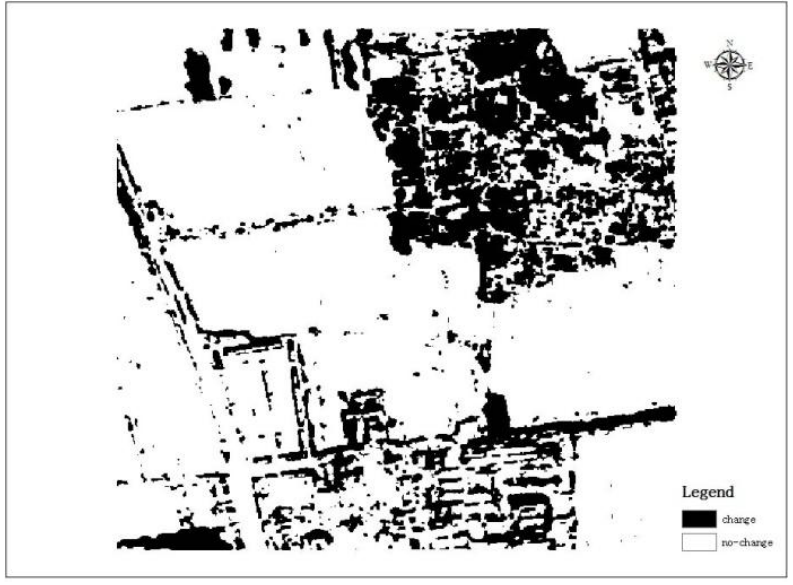
Figure 6. Change maps obtained using the proposed multi-algorithm fusion applied to ( a ) data set 1 and ( b ) data set